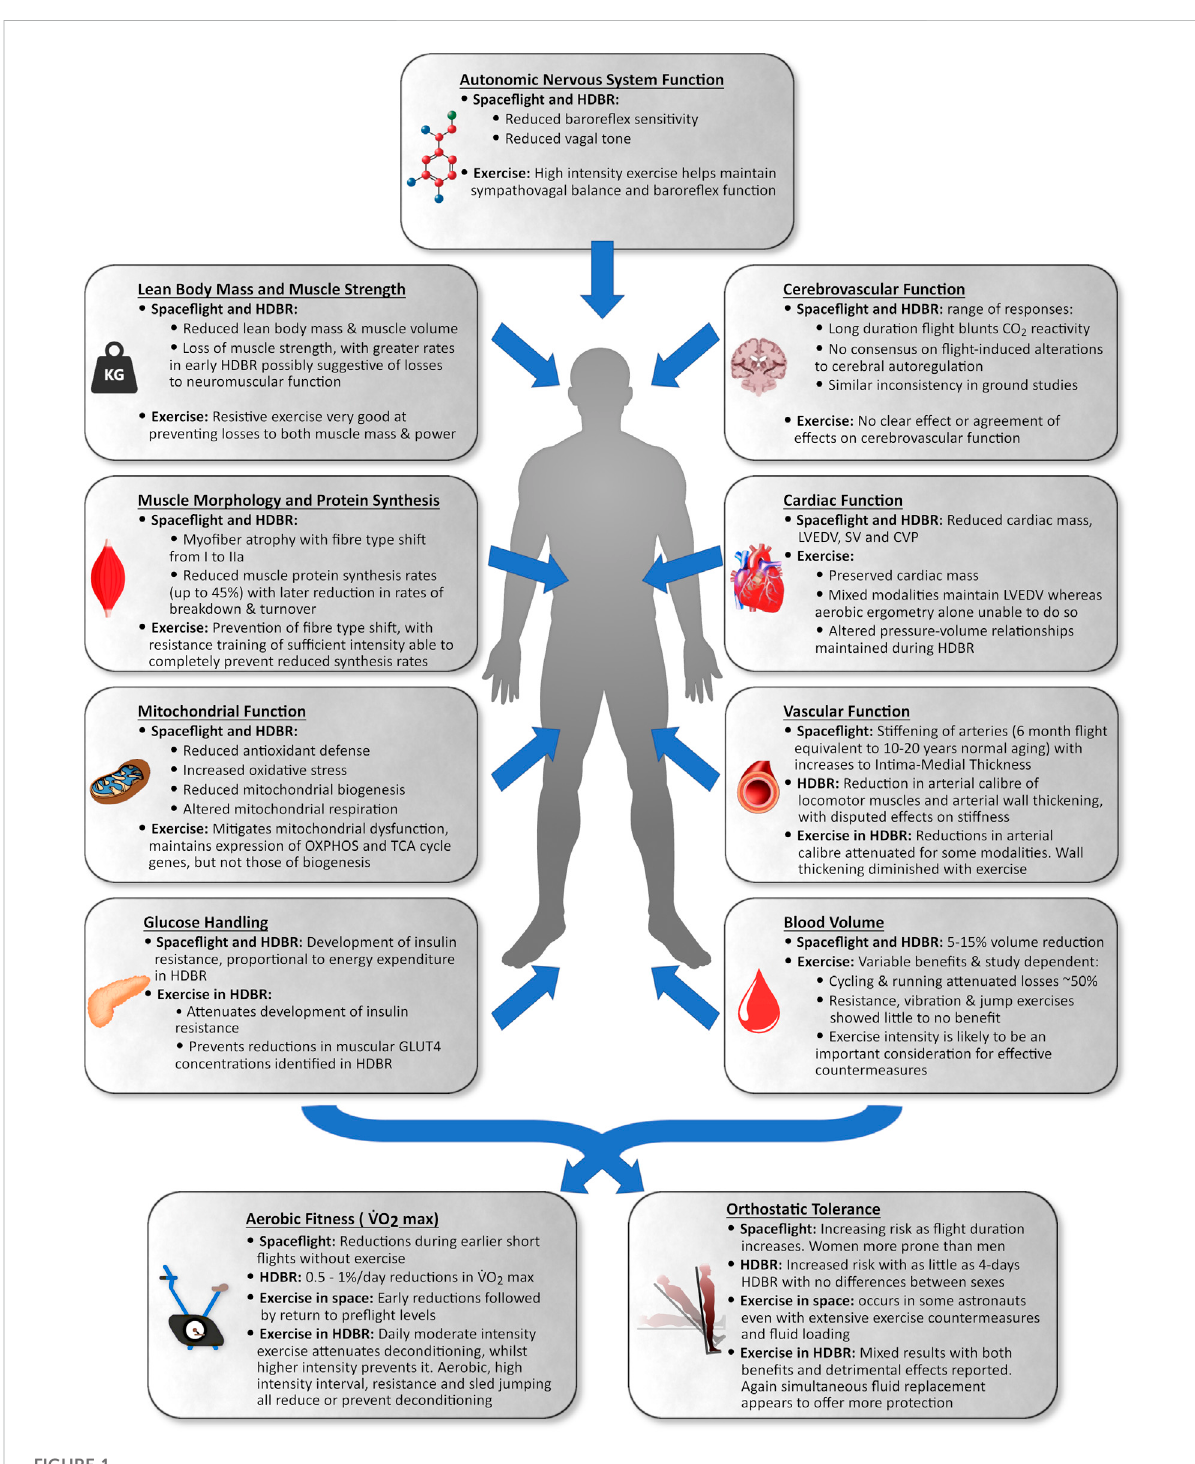
FIGURE 1 Summary of the impact of space fl ight and head-down tilt bedrest (HDBR) in young to middle-aged adults and the impact of exercise as a countermeasure on various portions of the cardiovascular and musculoskeletal